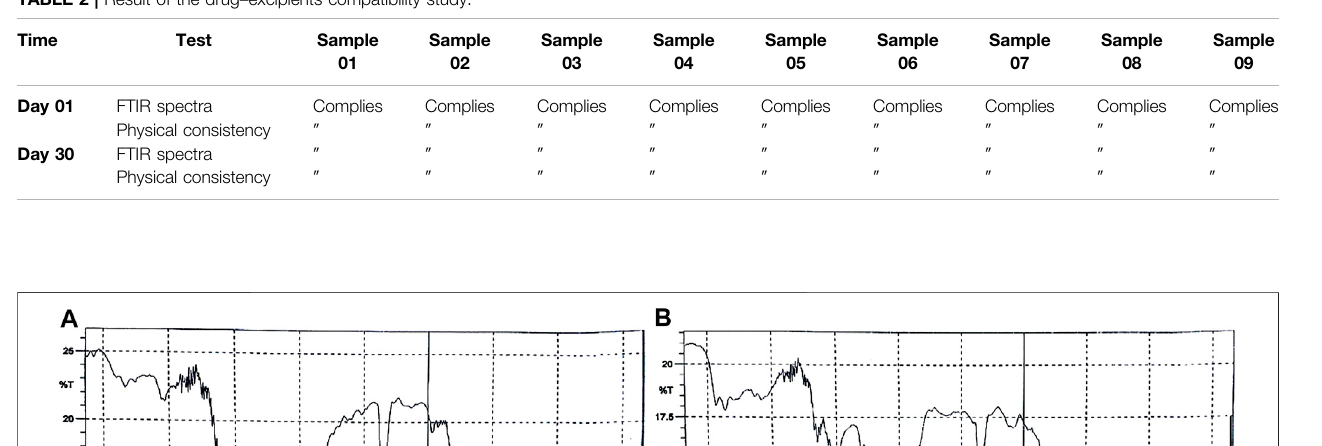
TABLE 2 | Result of the drug – excipients compatibility